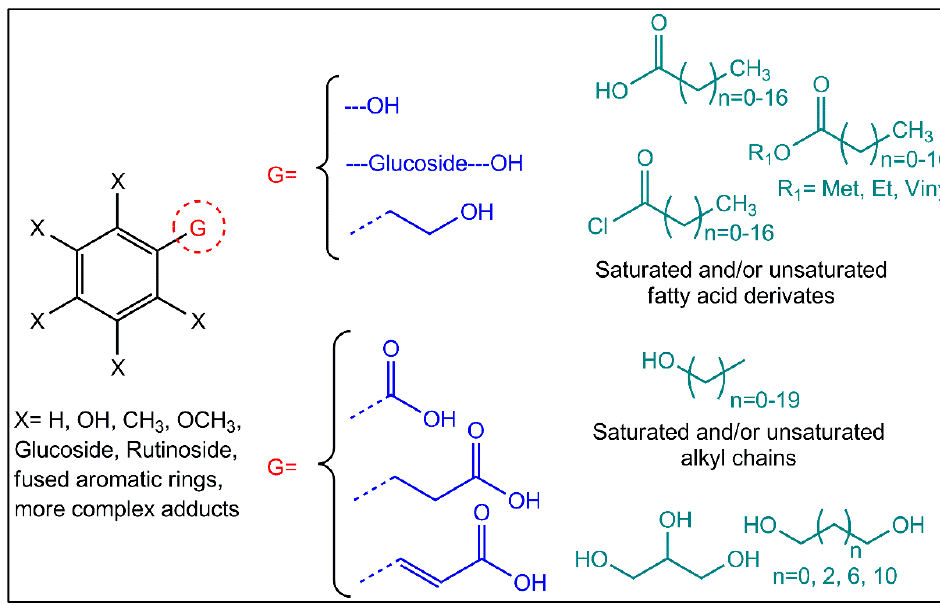
Figure 1. Schematic representation of the polyphenolic functionalities that can be esterified with the main reactants employed in the literature. G represents the functional group of the polyphenolic moiety that is involved in the reaction.